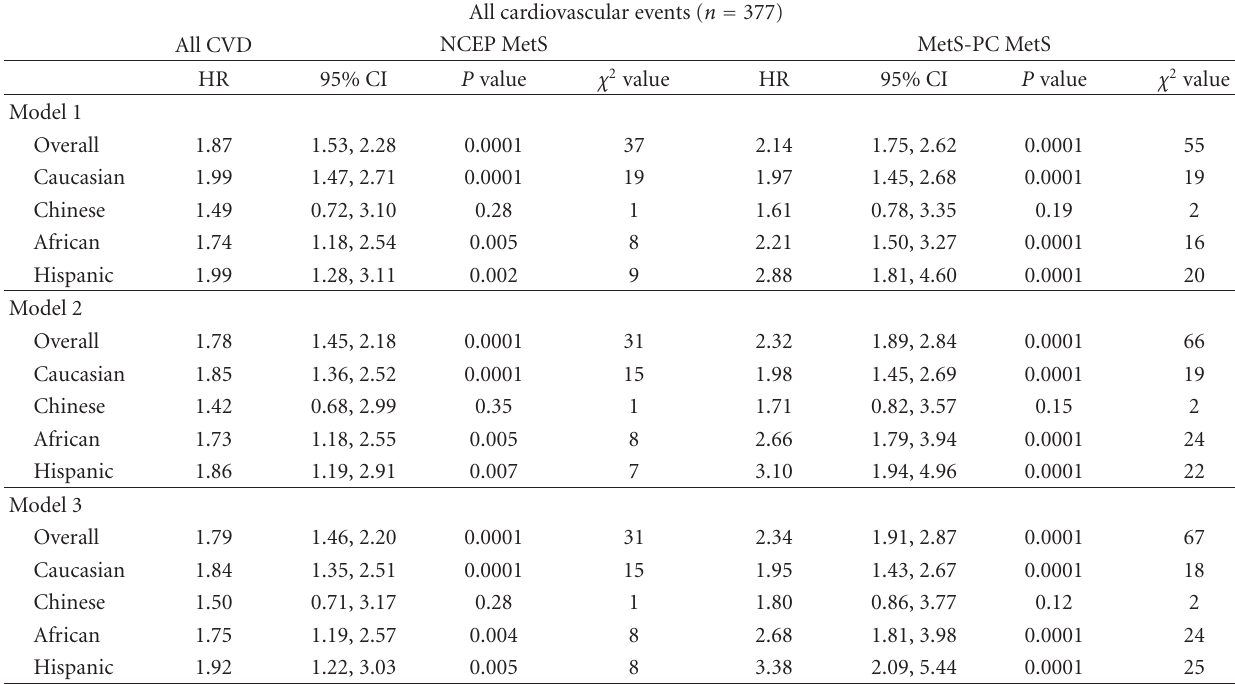
Table 4: Cox proportional hazard models illustrating the association of NCEP and binary MetS-PC MetS definitions with CVD events in the MESA